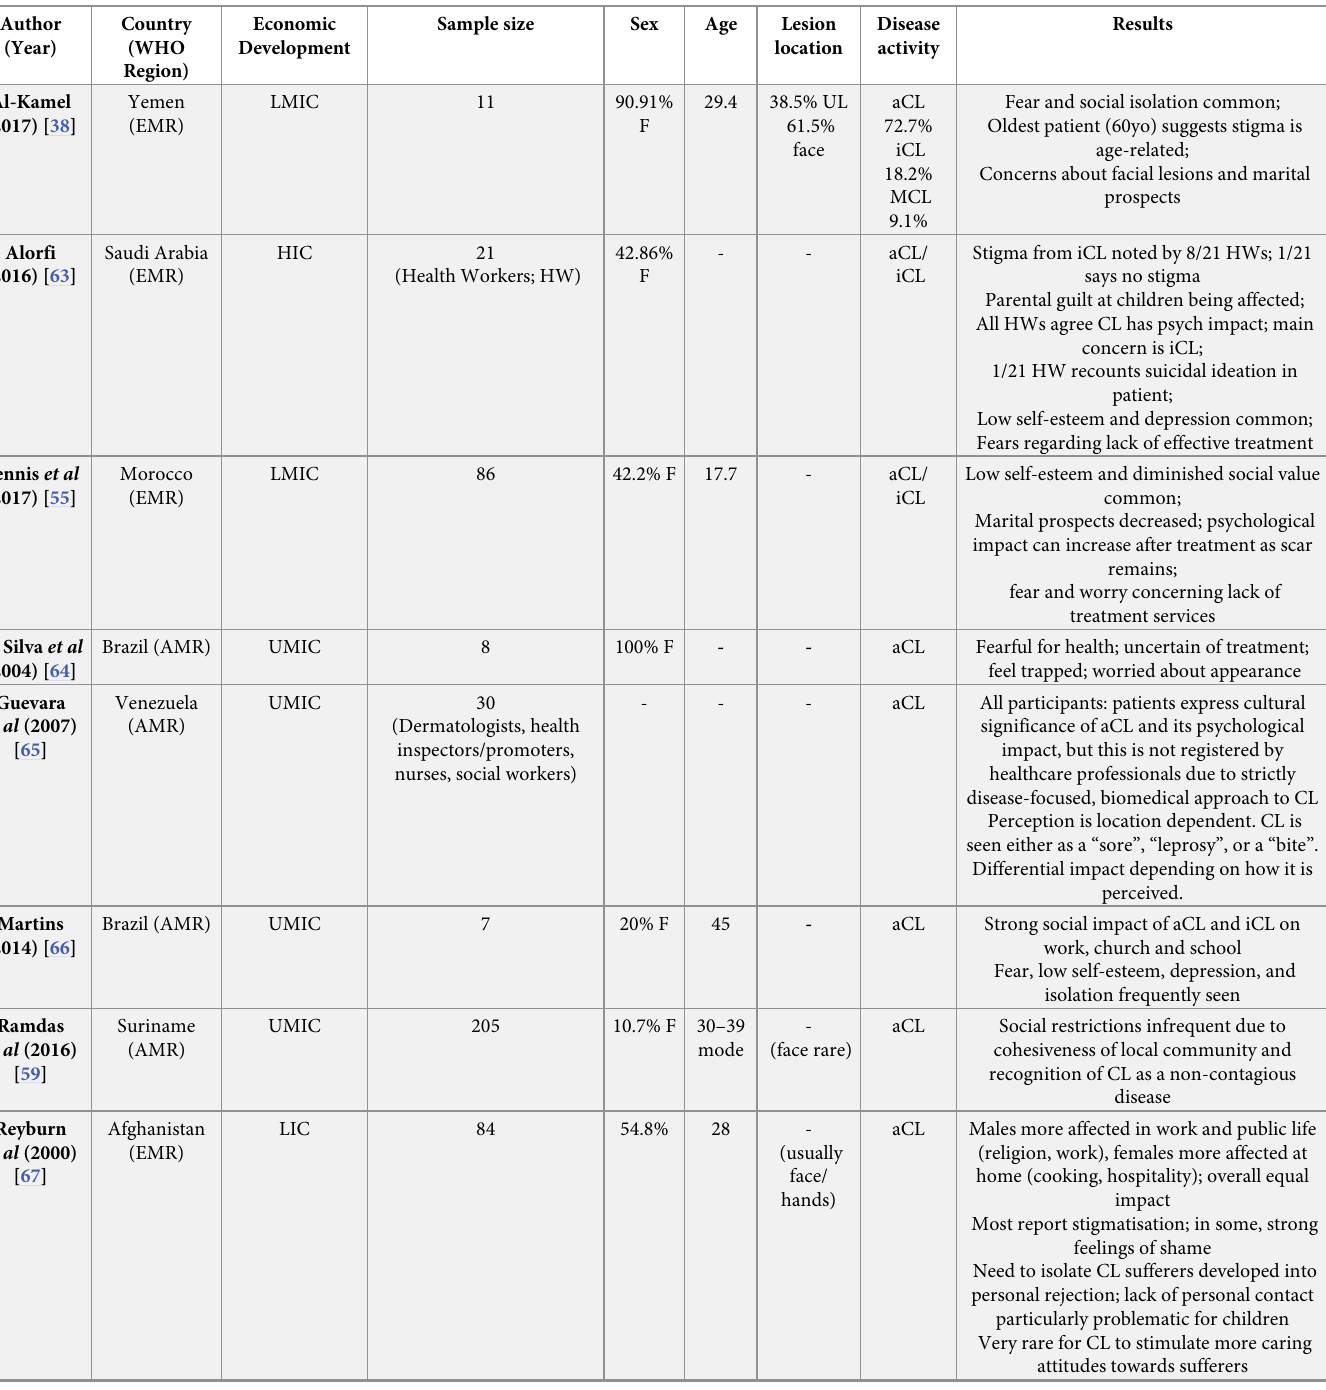
Table 3. Qualitative